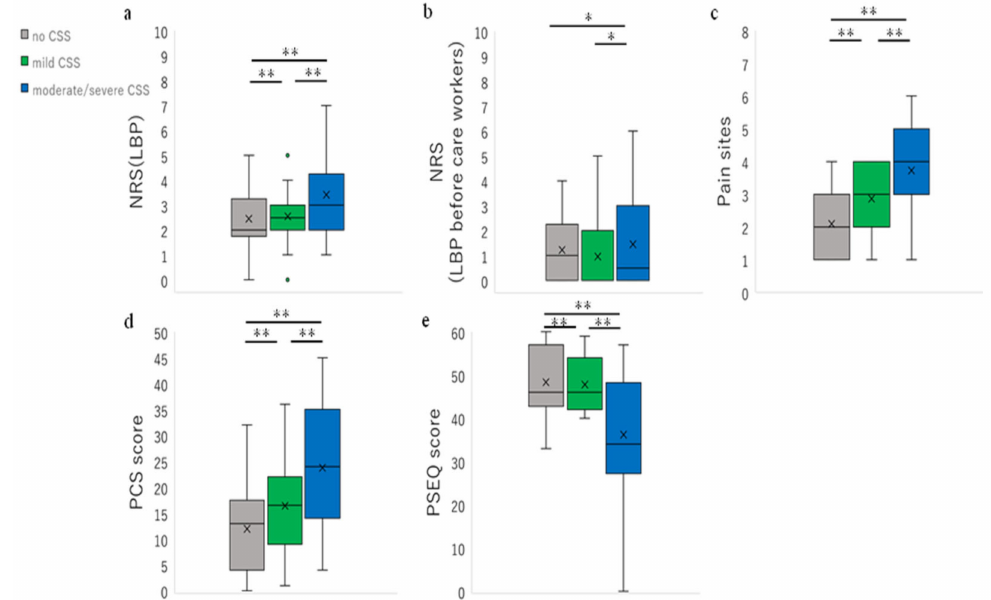
Figure 2. The difference in pain-related factors between CSS severity groups. ( a ) The difference in NRS (LBP) between CSS severity groups. ( b ) The difference in NRS (LBP before becoming caregivers) between CSS severity groups. ( c ) The difference in pain sites between CSS severity groups. ( d ) The difference in PCS scores between CSS severity groups. ( e ) The difference in PSEQ scores between CSS severity groups. **: p < 0.01, *: p <